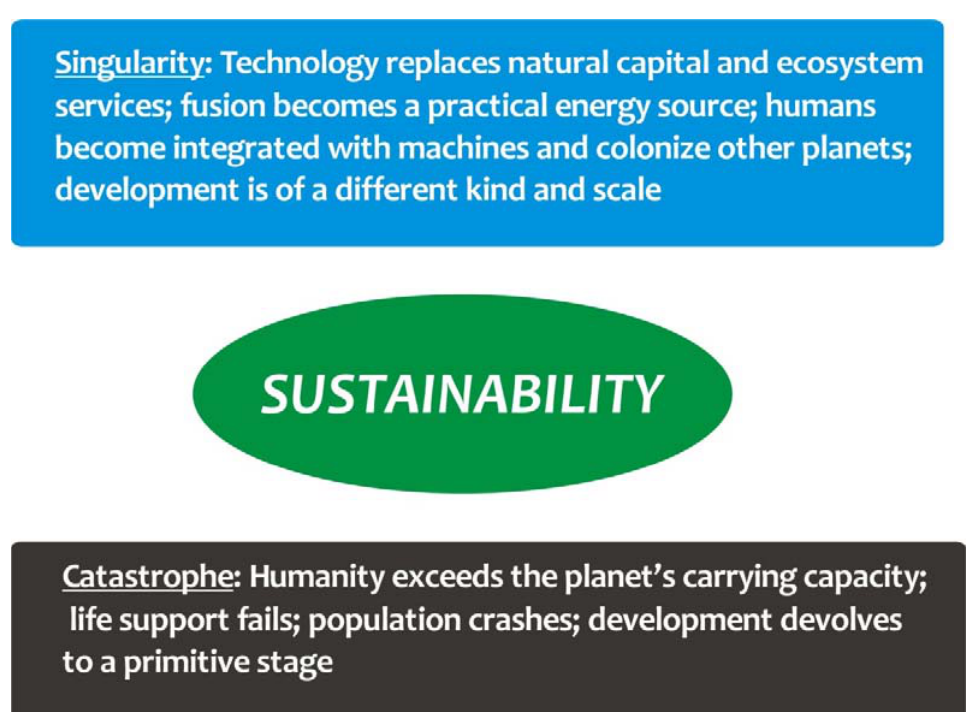
Figure 1. Sustainability as a hypothetical middle ground between alternative outcomes.